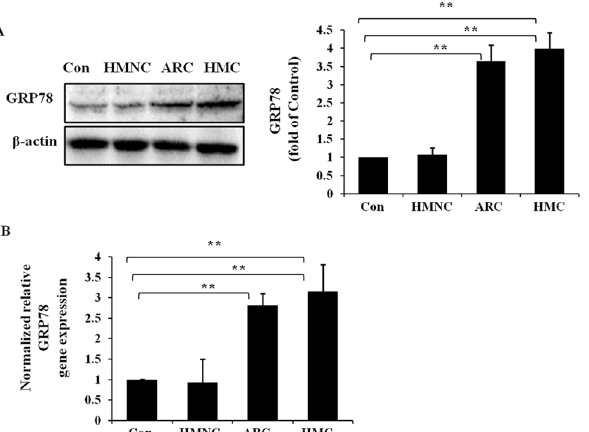
doi:10.1371/journal.pone.0137582.g002